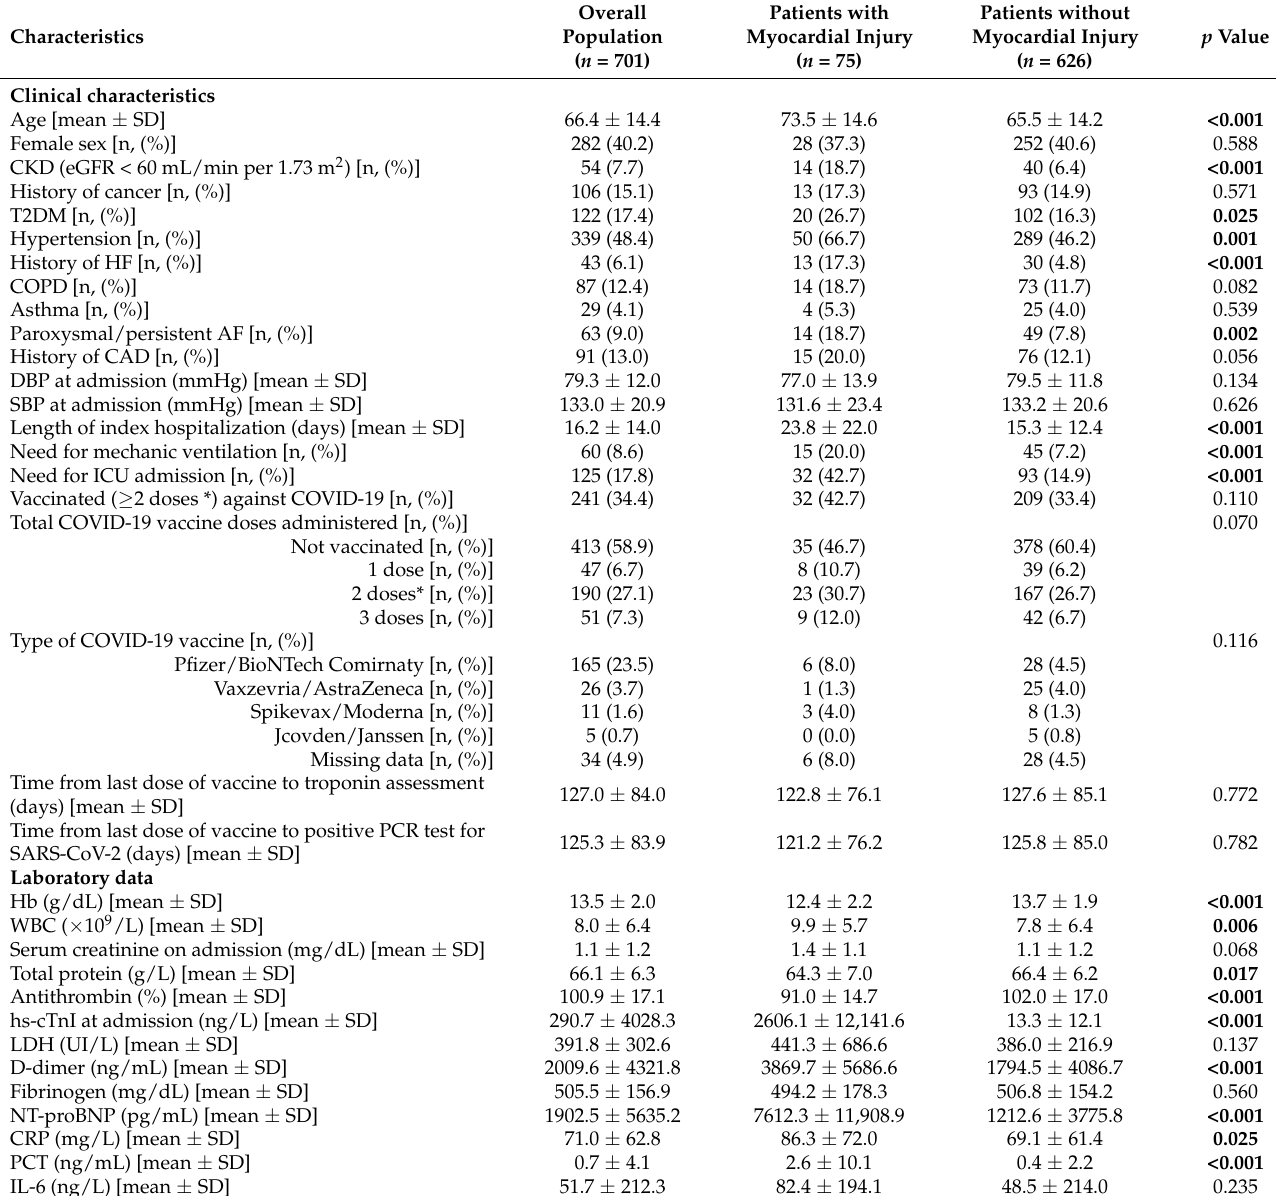
Table 1. Baseline characteristics of the overall population, according to the presence or absence of myocardial injury during index hospitalization for